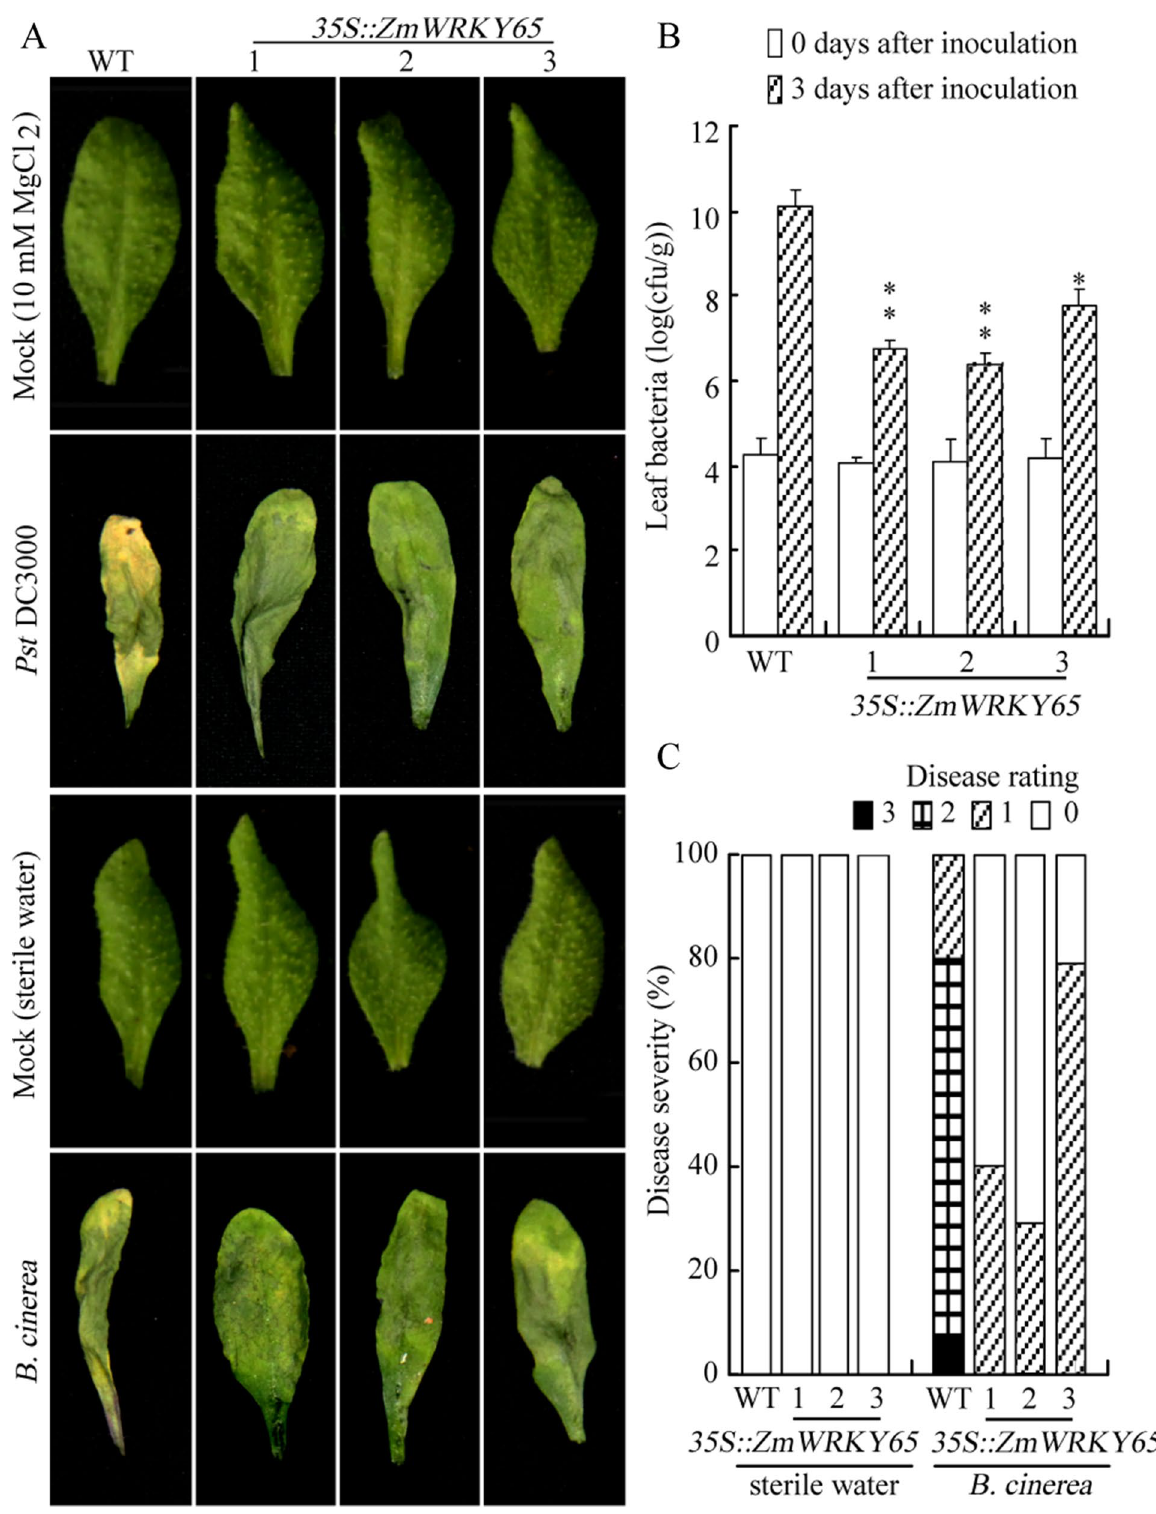
Figure 7. Fungal and bacterial pathogen tolerance of transgenic plants. ( A ) The phenotypes of WT and ZmWRKY65 transgenic Arabidopsis plants under bacterial and fungal treatments. ( B ) Bacterial pathogen ( P. syringae ) response of three independent transgenic Arabidopsis lines and WT. The bacterial population was investigated 3 days after the plants were inoculated with 107 CFU/mL of Pst . DC3000. The results are averages of three replicates. Vertical bars indicate ± SE of three replicates. *, ** indicate significant differences in comparison with the WT lines at 0.01 < P < 0.05 and P < 0.01, respectively. ( C ) Histogram of fungal disease ( B. cinerea ) symptoms of three independent transgenic Arabidopsis and WT lines 8 days after the plants were inoculated with sterile water or with 2 × 10 5 conidiospores/mL. 0–3 represent the disease rating: 0, no infection/ necrosis; 1, 1–4 leaves showing some necrosis; 2, 5–10 leaves showing necrosis; 3, dead